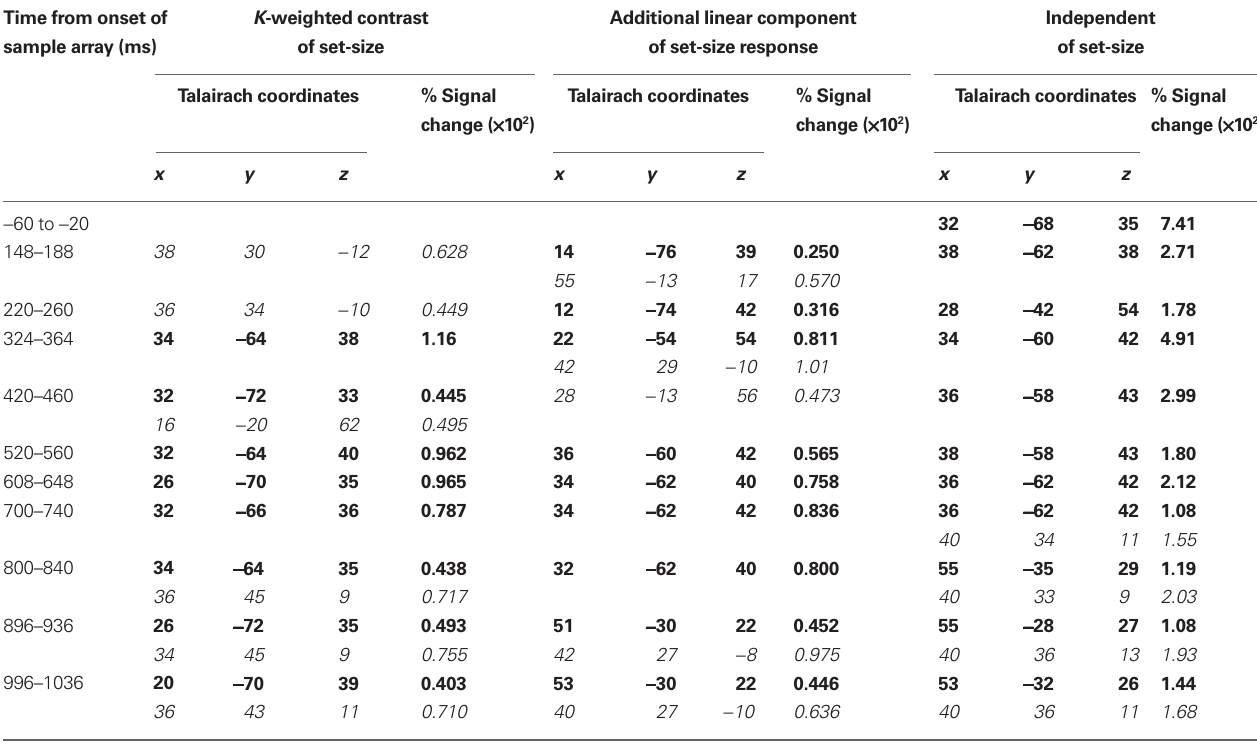
Table 2 | Peak coordinates of source-localized contralateral